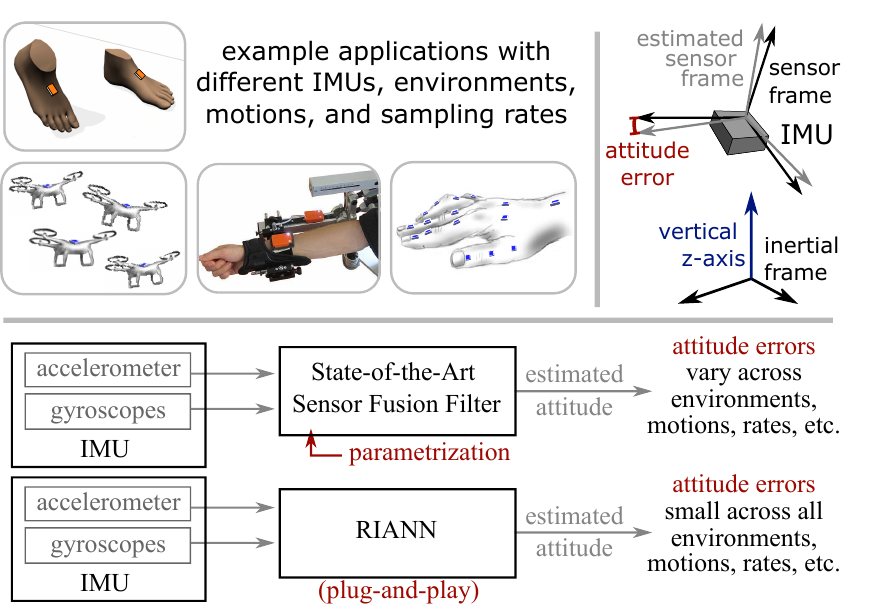
Figure 1. IMUs are used in various applications to measure an object’s attitude with respect to the vertical axis. A robust attitude estimator, unlike conventional filters, performs well across the different sensor hardware, motion characteristics, environmental conditions, and sampling rates without application- or trial-specific parameter tuning. Graphic based on